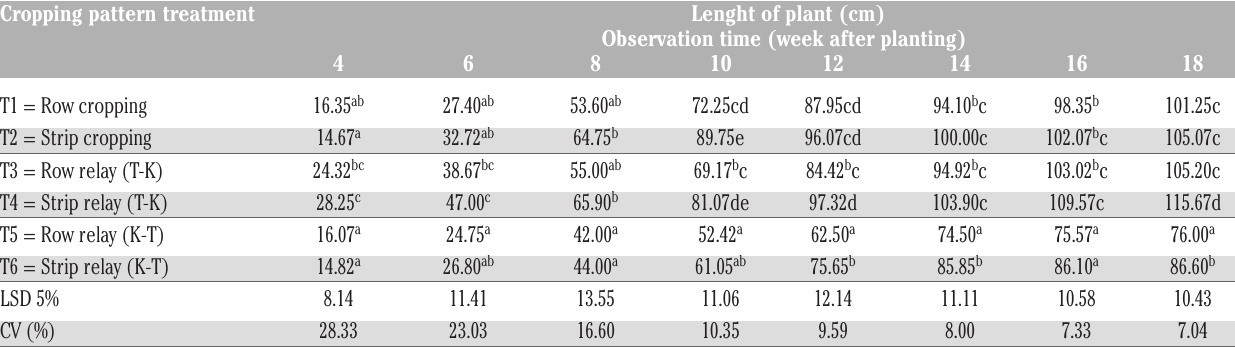
Table 1. Lenght of curcuma plants on different cropping pattern. Cropping pattern treatment Lenght of plant (cm) Observation time (week after planting)